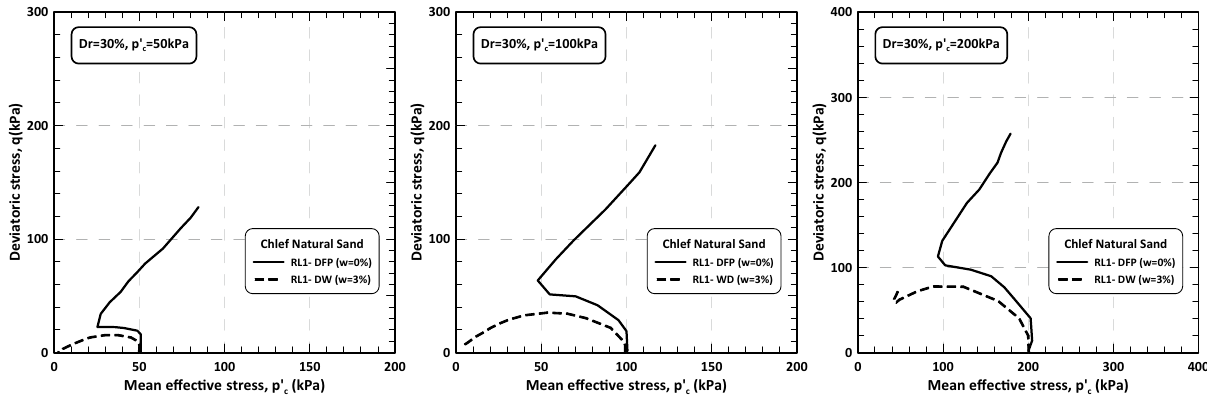
Fig. 12 Effective stress path curves of sand unreinforced and reinforced with one layerof geotextile under different confining pressures: a p ′ = 50 kPa, b p ′ = 100 kPa, and c p ′ = 200 kPa c c c